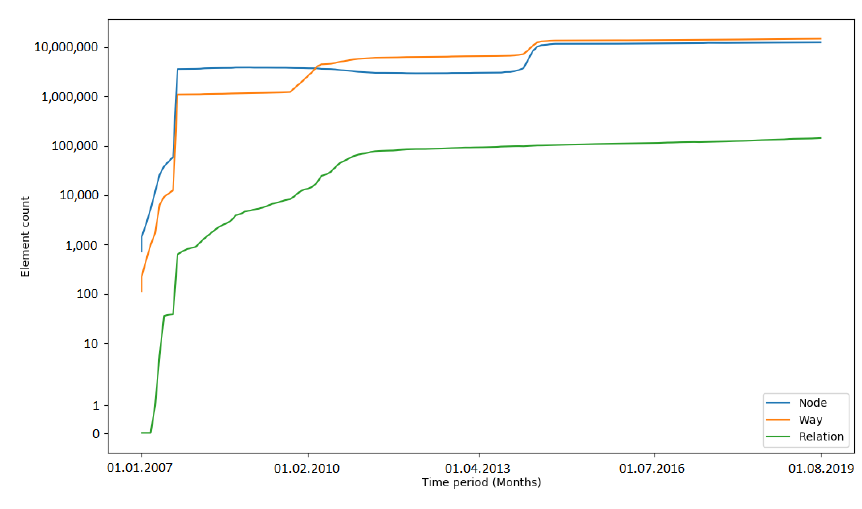
Figure 1. Contributions in the